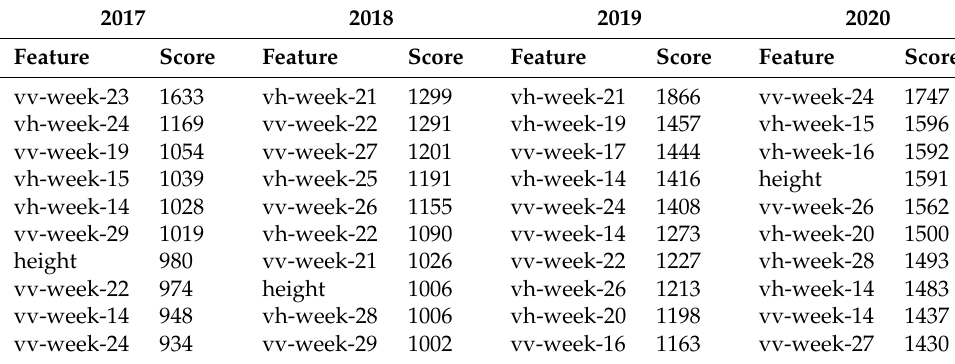
Table A2. Comparisons of feature importance scores over different